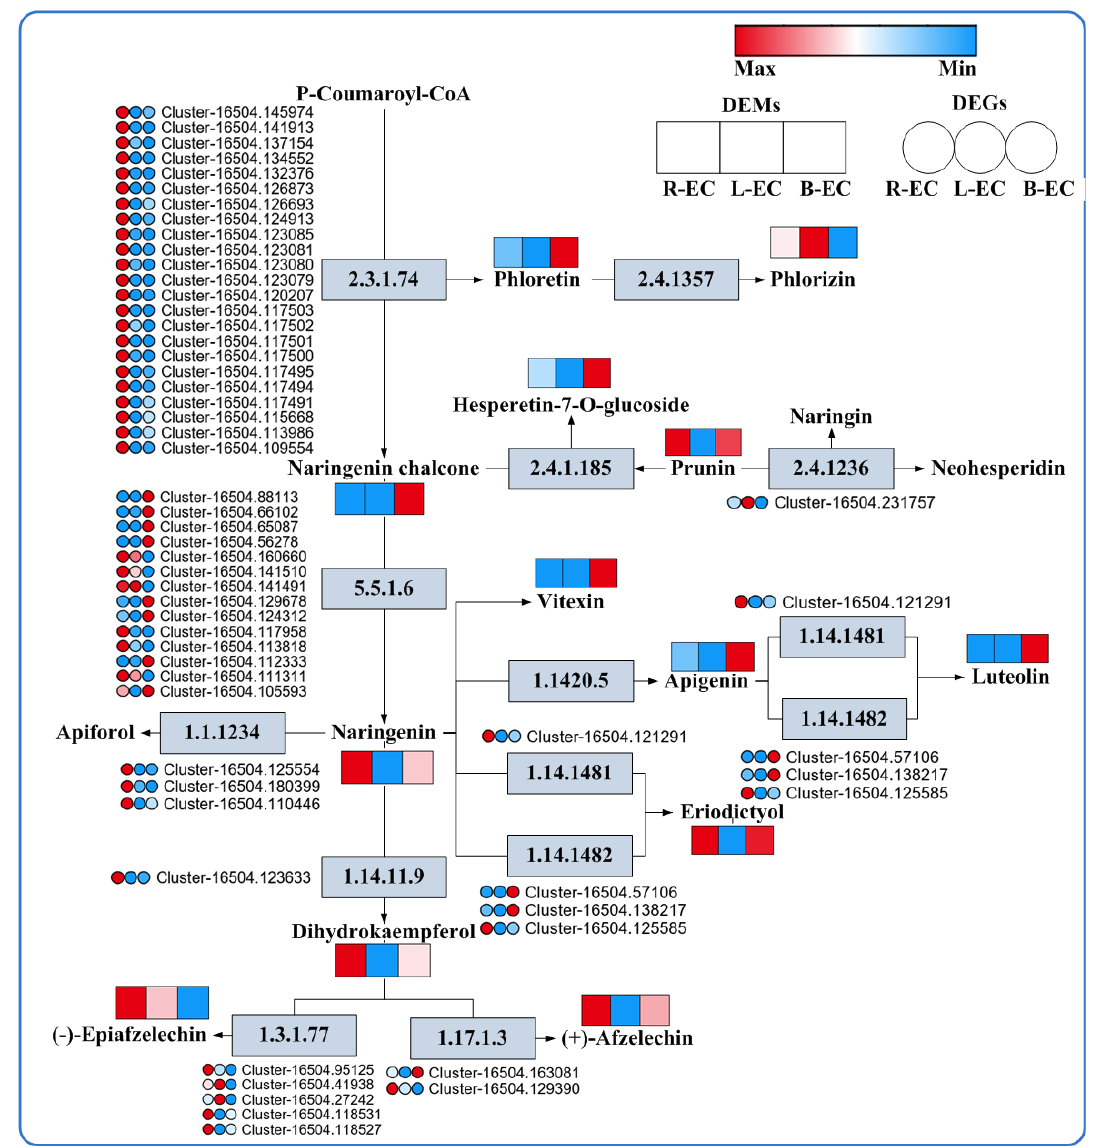
Figure 11. Analysis of DEGs and DEMs of flavonoid metabolic pathways among Korean pine R-EC, L-EC, and B-EC cell lines. 2.3.1.74: chalcone synthase; 2.4.1236: flavanone 7-O-glucoside 2 ″ -O- β -L- rhamnosyltransferase; 5.5.1.6: chalcone iso 1.1.1234: flavanone 4-reductase; 1.14.1481: flavonoid 3′ , 5′ -hydroxylase; 1.14.1482: flavonoid 3′ -monooxygenase; 1.14.11.9: pomelo peel 3-dioxygenase; 1.3.1.77: anthocyanin reductase; 1.17.1.3: leucocyanidin reductase.